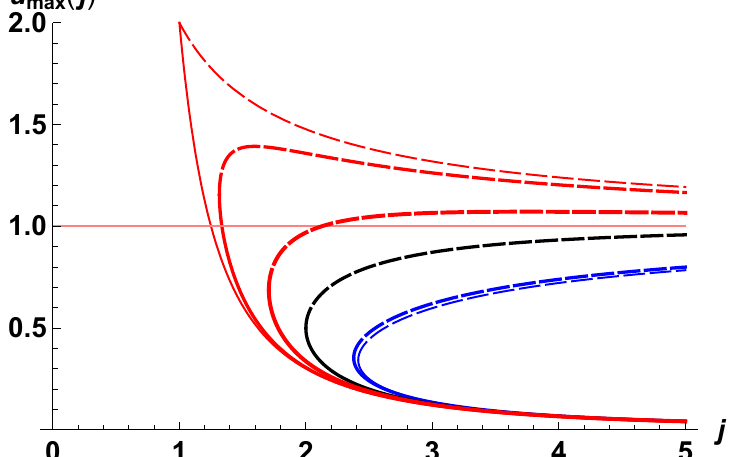
Figure 2. Not every combination of ( j , u ) is realizable. Trajectories are completed only when, for a given initial angular momentum j 0 , values u are within the “domain of physical motion”: between u min = 0 and u max = u 1 ( ω , j 0 ) . Colored u -curves, composed of branches u 1 (lower, solid) and u 2 (upper, dashed), correspond to scenarios with BH spin-values (from the left-most to the right-most): ω = − 0.5 (red), ω = − 0.45 (red), ω = − 0.25 (red), ω = 0 (black), ω = + 0.45 (blue), ω = + 0.5 (blue). Horizontal line u = 1 marks the static limit (where metric tensor component g 00 = 0). In this ( j , u ) -space, the (corresponding to the test-body) state-point starts at the point ( j = j “moves” upward (along the vertical line j = j 0 ) until reaching ( j 0 , u 1 ( j 0 , ω BH )) —on the lower branch of the u -curve corresponding to the encountered black hole’s spin ω BH —which corresponds to the trajectory’s periastron in the physical space, then the body “reflects”, and returns downward (along the vertical line j = j 0 ) to point ( j = j 0 , u = 0 ) which is now the exiting value at the